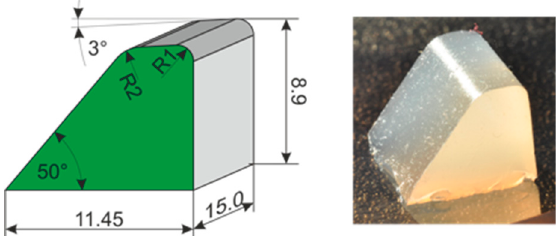
Figure 4. (Color online) Schematic diagram and photograph of the synthetic silicone model of one of the vocal folds (distances are in millimeters). R1: radius 1 mm; R2: radius 2 mm,.